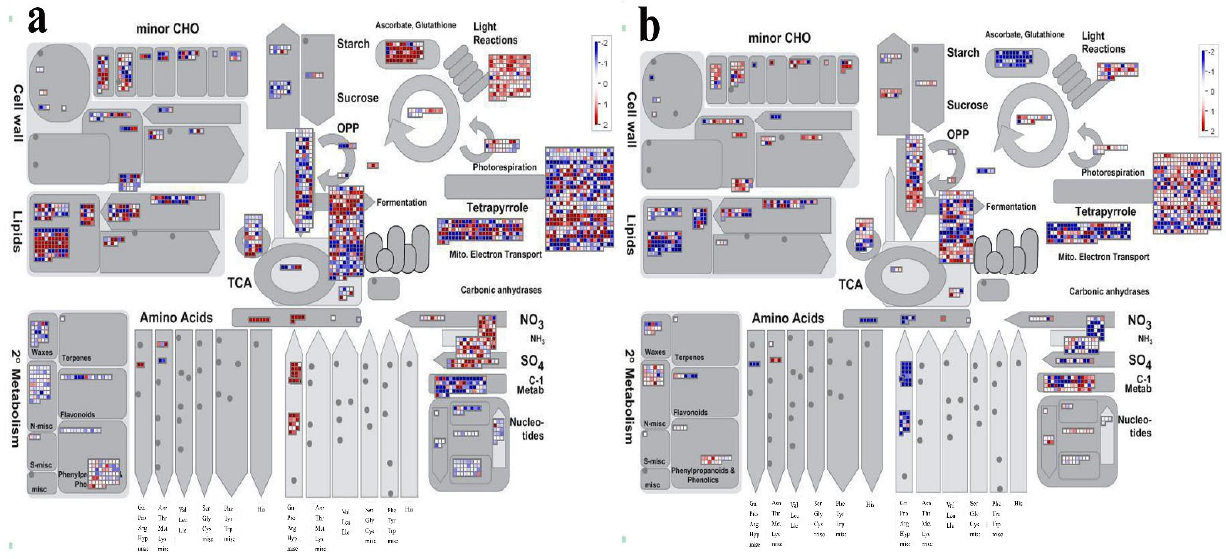
Figure 7. Distribution of up − (in red) and down − (in blue) regulated genes in metabolic pathways in leaves ( a ) and roots ( b ) under low − Pi treatment.